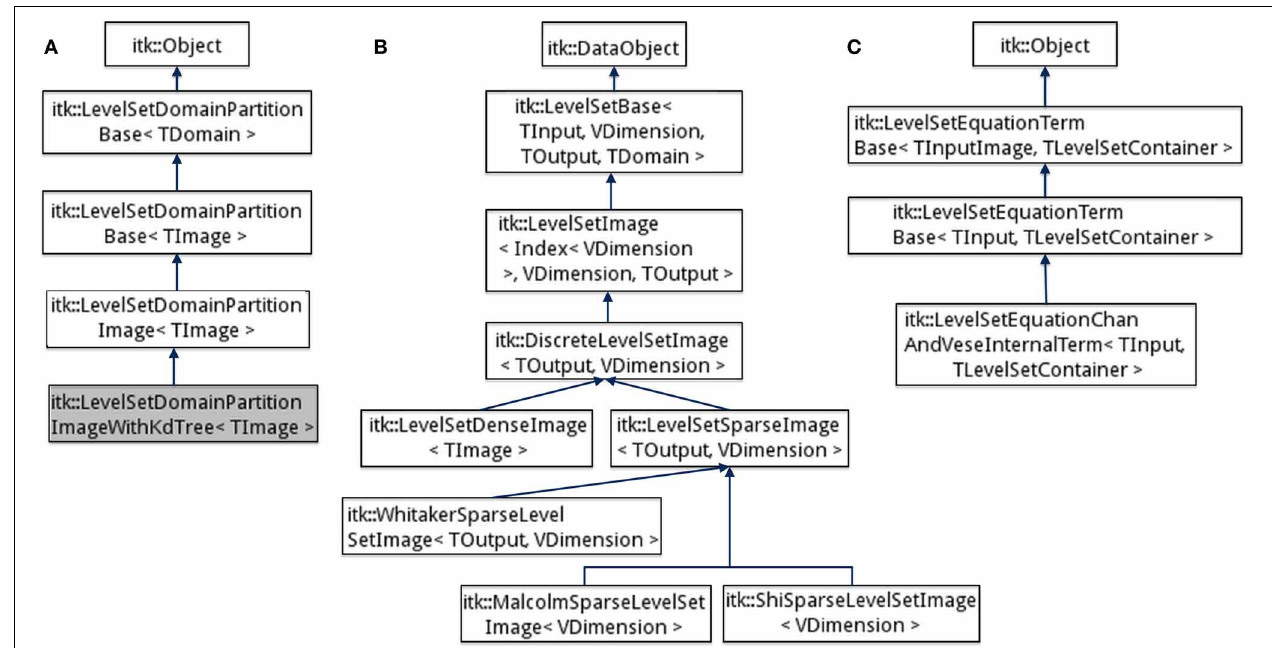
FIGURE 3 | Inheritance diagrams for (A) Domain partitioning classes, (B) Level-set function, and (C) Level-set equation term classes in the ITK v4 framework.